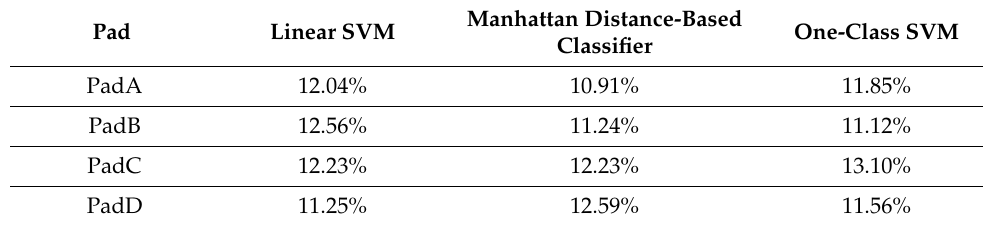
Figure 7. EER for removal of the lower 20% features. Table 5. EER for removal of the lower 20% features.